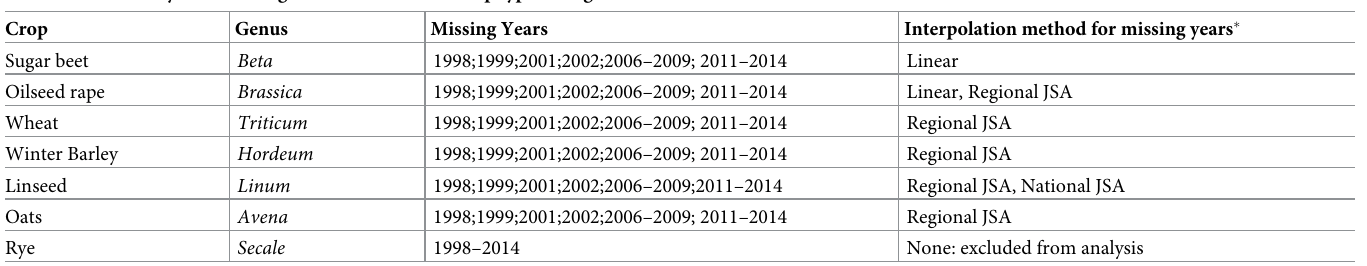
Table 1. Availability of EDINA agcensus data for each crop type in England. Crop